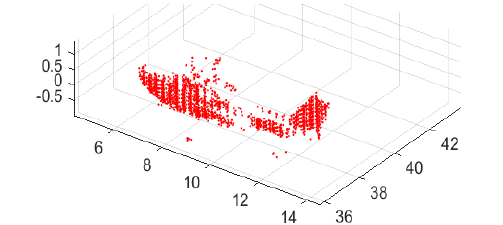
Figure 12. Point cloud from method 3 at ~7m/s velocity form 40 m object distance with